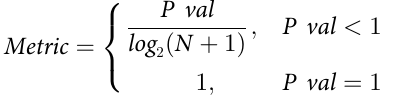
S1 Fig. ROC curves for randomly selected targets showing the performance of different approaches.